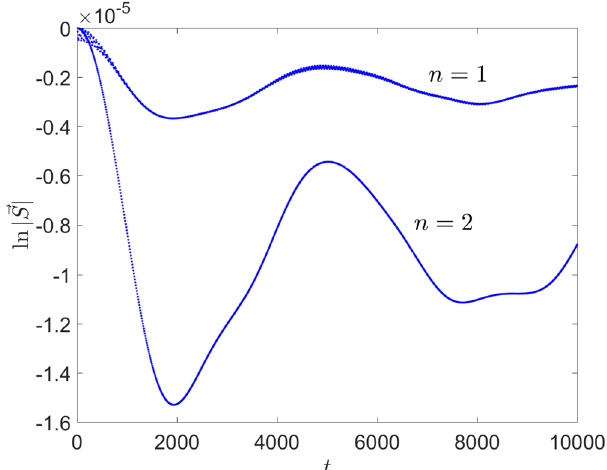
1 = and =  1000 . The initial states are |1, − 〉 for the graph of three sites ( n = 1), | −〉 + | −〉 ( 2, )/ 2 for the graph of five sites ( n =